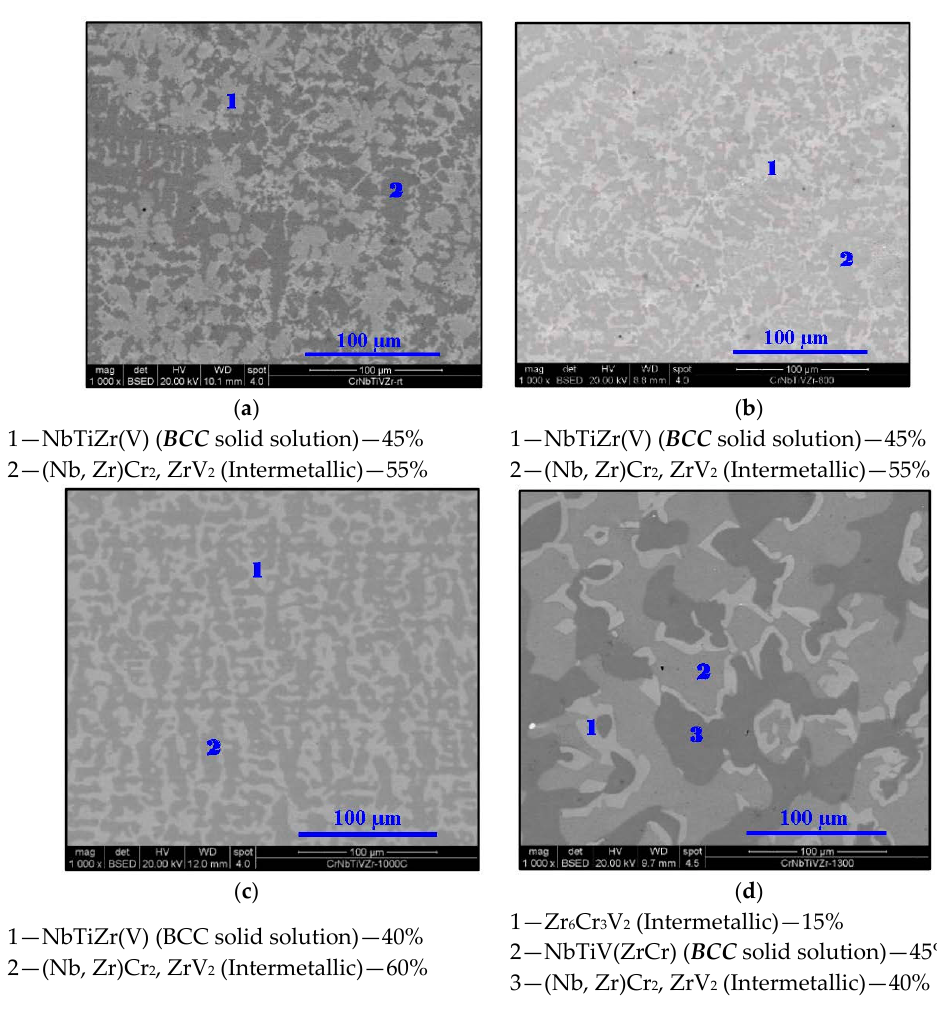
Figure 1 . SEM micrographs of Cr 20 Nb 20 Ti 20 V 20 Zr 20 at ( a ) 25 °C, ( b ) 800 °C, ( c ) 1000 °C, and ( d ) 1300 °C Figure 1. SEM micrographs of Cr 20 Nb 20 Ti 20 V 20 Zr 20 at ( a ) 25 ◦ C, ( b ) 800 ◦ C, ( c ) 1000 ◦ C, and ( d ) 1300 ◦ C at 1000× magnification in BSE mode. at 1000 × magnification in BSE mode. Materials 2018 , 11 , x FOR PEER REVIEW